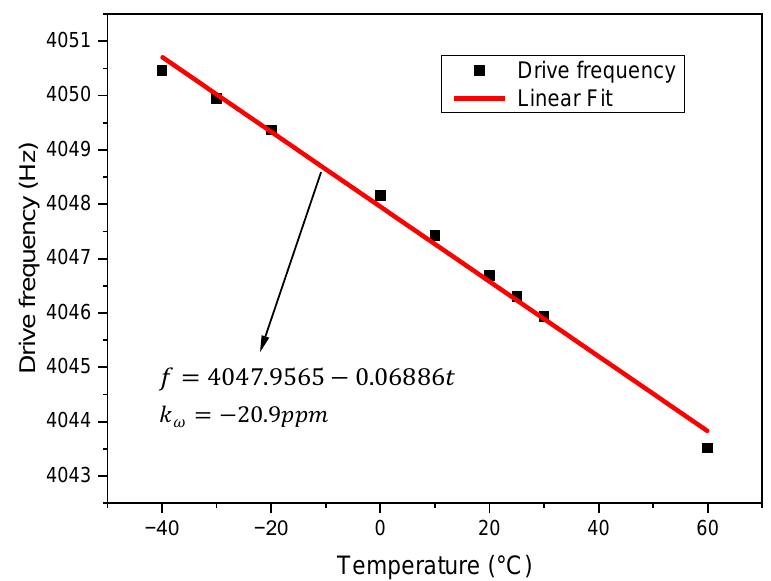
Figure 2. Influence of temperature change on the resonant frequency of the HDRG.